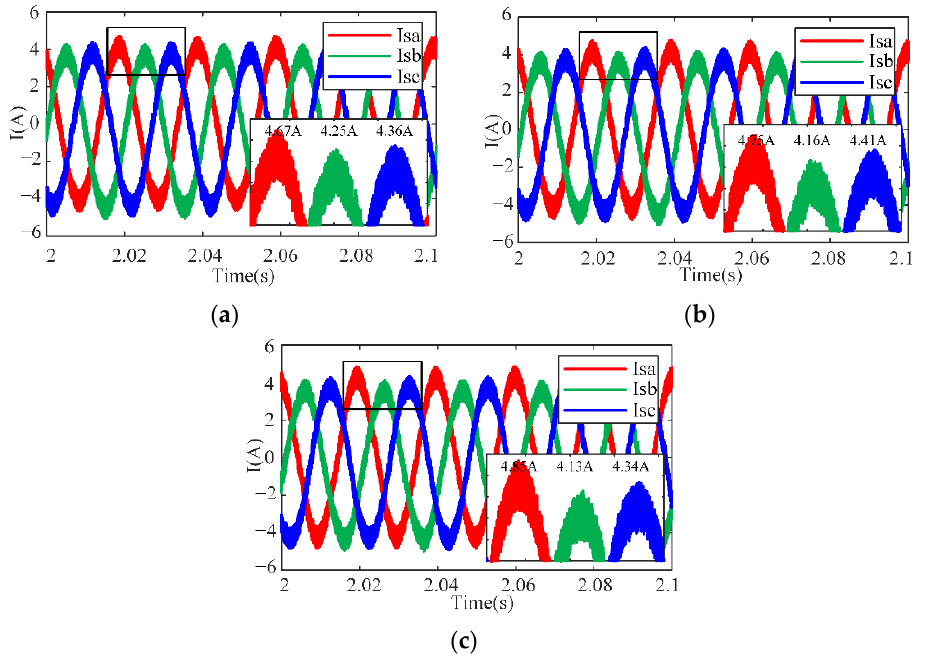
Figure 6. Stator current of the motor at 30% T N : ( a ) healthy condition. ( b ) B, C phase in series with 1 Ω resistors. ( c ) B, C phase in series with 2 Ω resistors.